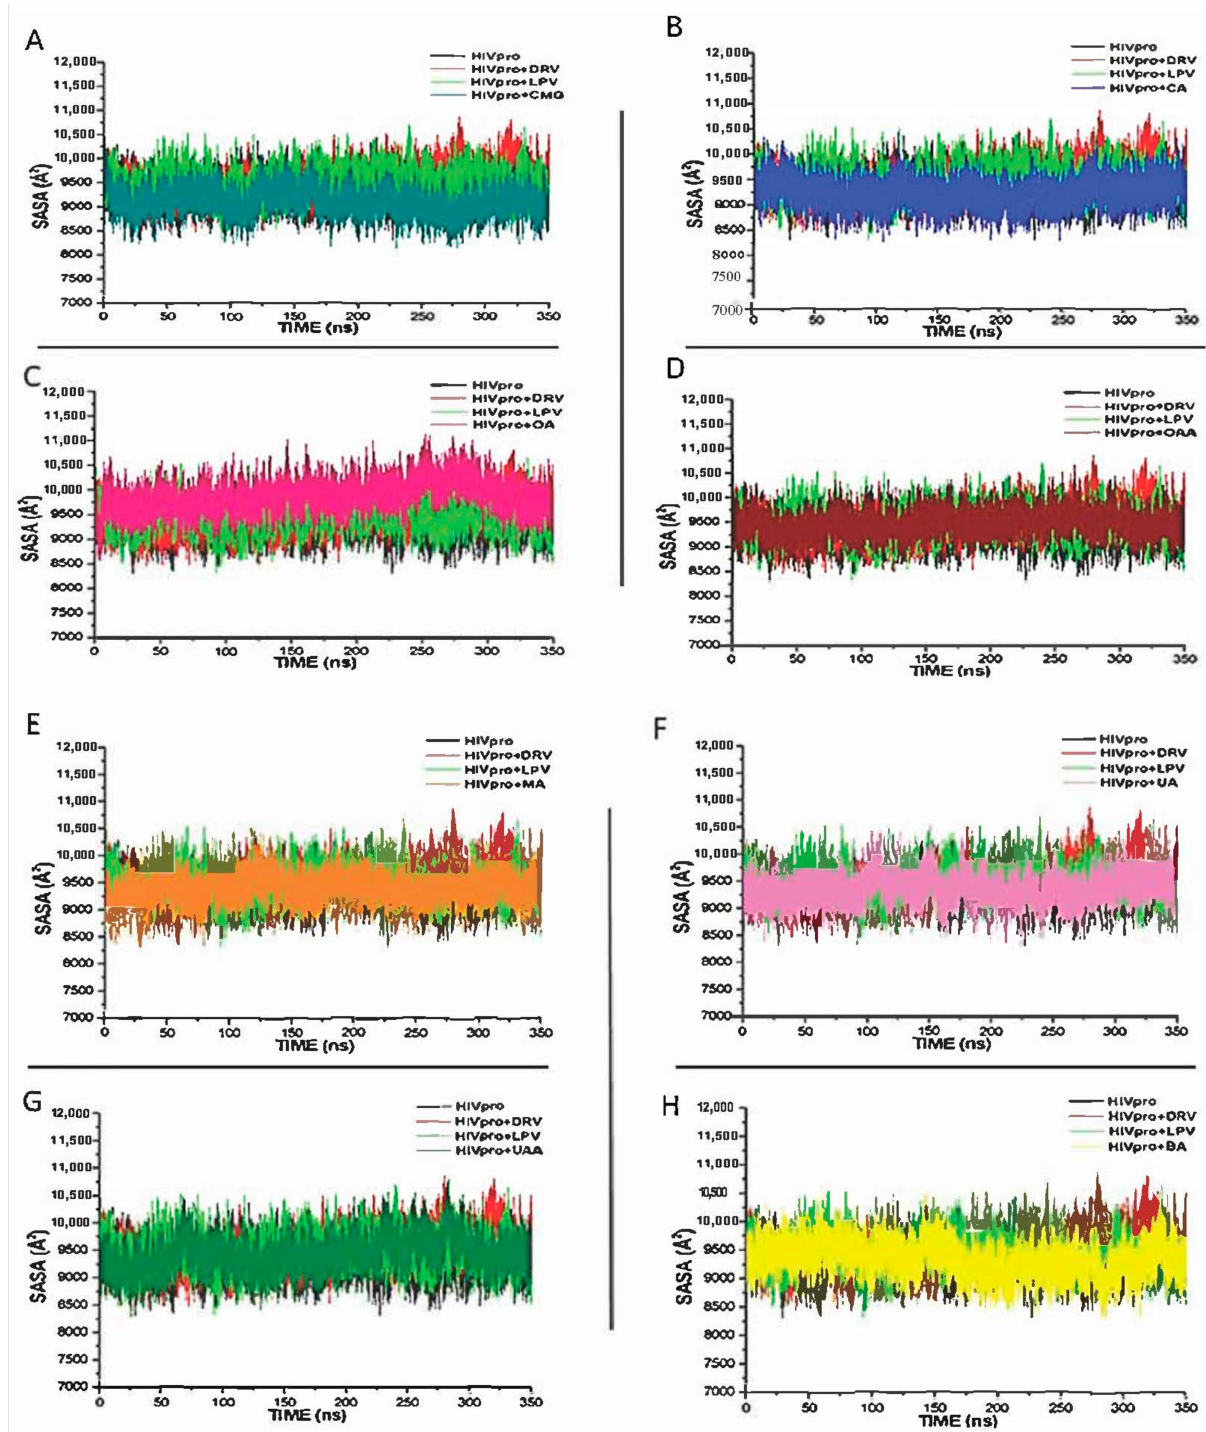
Figure 5. Comparative SASA plots of residue-based average C- α fluctuations of free HIVpro and that bound with LPV, DRV, and ( A ) CMG, ( B ) CA, ( C ) OA, ( D ) OAA, ( E ) MA, ( F ) UA, ( G ) UAA and ( H ) BAA